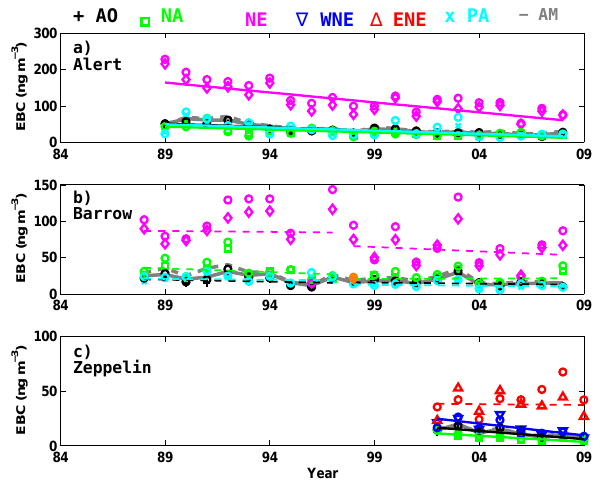
Fig. 14. Box-whisker plots over the sulphate concentration asso- ciated to each cluster at Alert (a) , Barrow (b) , and Zeppelin (c) , where the box boundaries are set to mark the 25th and 75th per- centile of the data whereas the whiskers includes up to 99% of the data. Outliers outside this have not been plotted in order to empha- sis the difference between the different clusters. The horizontal line in each box marks the median